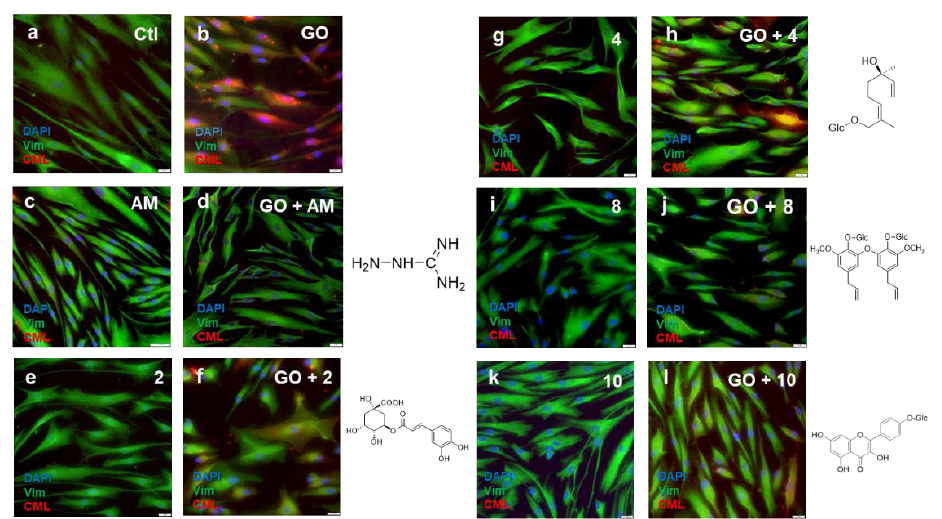
Figure 9. Images of immunofluorescent-stained glycation end products (CML) with the isolated compounds. CML (red); Vimentin (green); DAPI (blue); Ctl: control ( a,b ); aminoguanidine: 1.5 mM ( c , d ); compounds 2 : chlorogenic acid ( e,f ), 4 : (2 E , 6 R )-2, 6-dimethyl-2,7-octadien-6-ol-1- O - β - D -glu- copyranoside ( g,h ), 8 : 5,5’-diallyl-2,2’-diglucopyranosyl-3,3 ′ -dimethoxy diphenyl ether ( i,j ), 10 : kaempferol 4 ′ - O -glucopyranoside ( k,l ); GO: 1.25 mM ( b , d , f , h , j , l ); sample concentration: 25 μ g/mL.